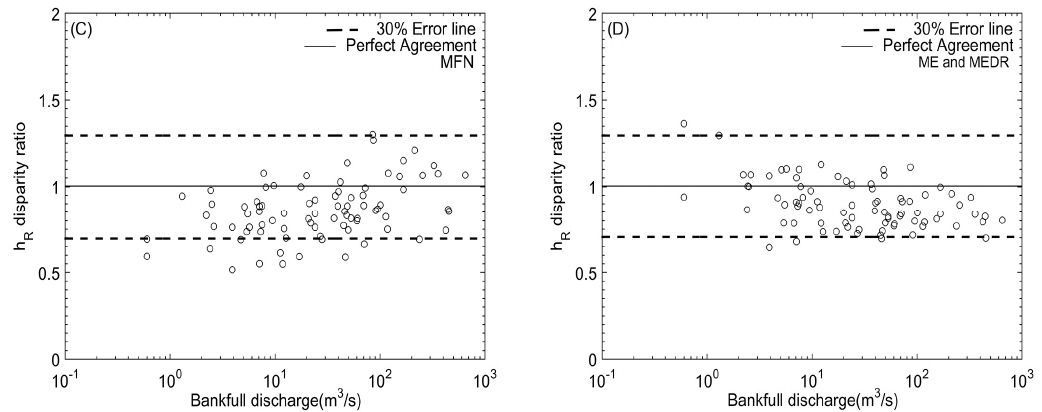
Figure 8. Scatter plot of disparity ratio h R against bankfull discharge for gravel bed channels [2,17,48,49]. ( A ) Millar’s Method; ( B ) MFE; ( C ) MFN; ( D ) ME and MEDR. Regime Channel Width and Depth